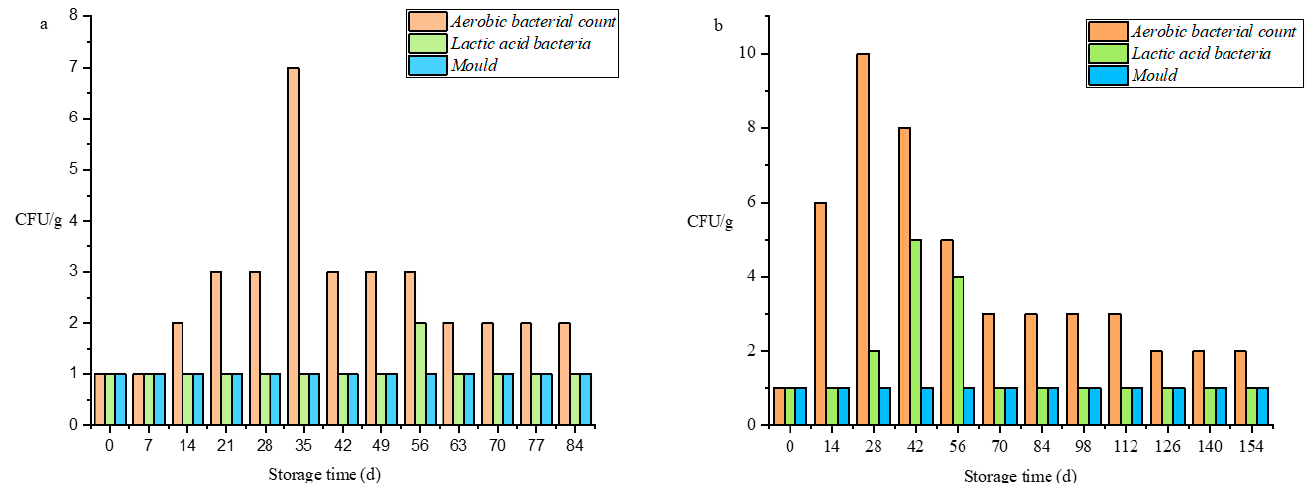
Figure 3. Changes of microorganism in Sichuan sauerkraut during storage at different temperatures (the temperature of ( a ) is 45 °C; the temperature of ( b ) is 35 °C). (the temperature of ( a ) is 45 ◦ C; the temperature of ( b ) is 35 ◦